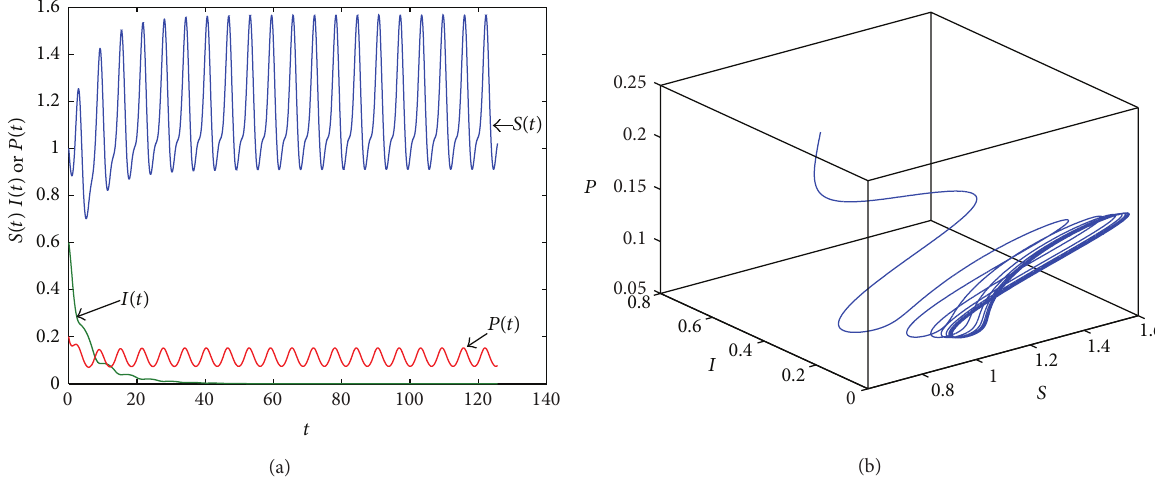
Figure 1: (a) The movement paths of 𝑆 , 𝐼 , and 𝑃 as functions of time 𝑡 . The graph of the trajectory in (𝑆,𝐼, 𝑃) -Space is shown in (b). 𝑅 ∗ = 0.9898 < 1 . The disease is extinct.